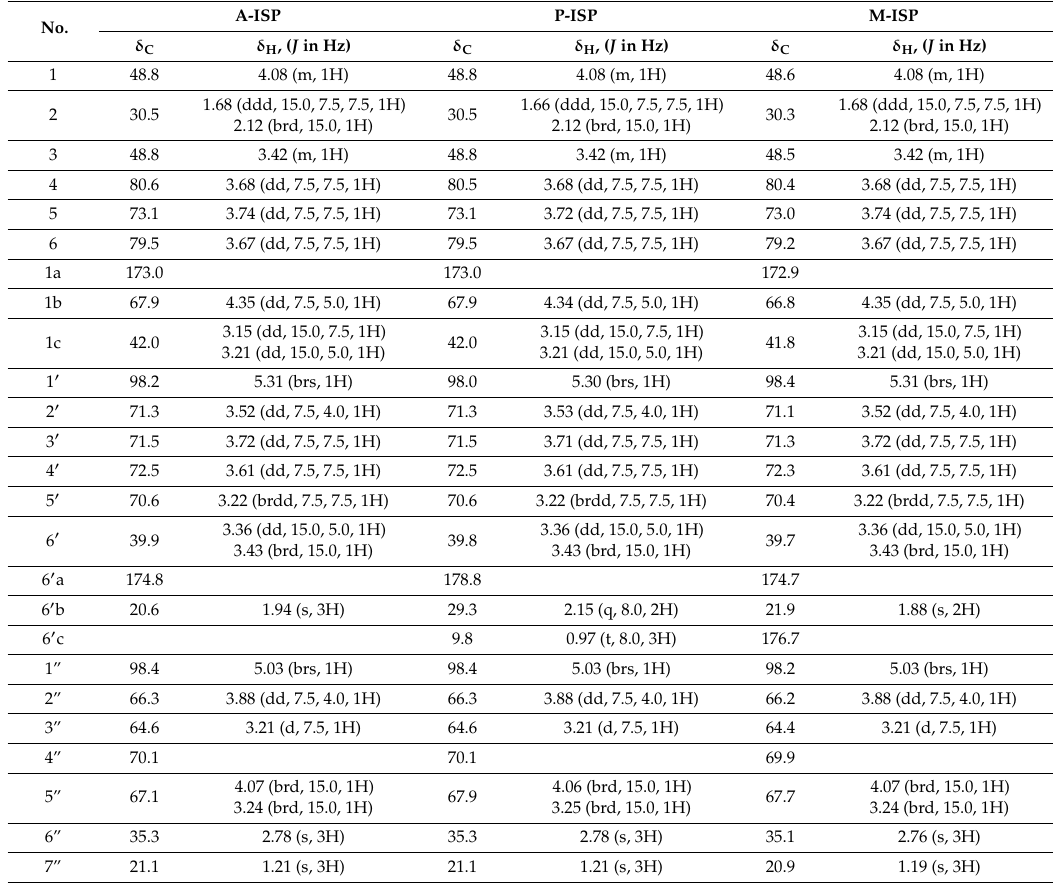
Table 1. 1 H and 13 C NMR data of novel ISP analogs in D 2